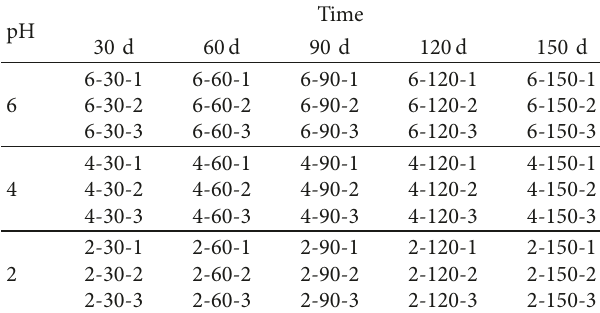
Table 1: Corrosion treatment scheme and specimen number.